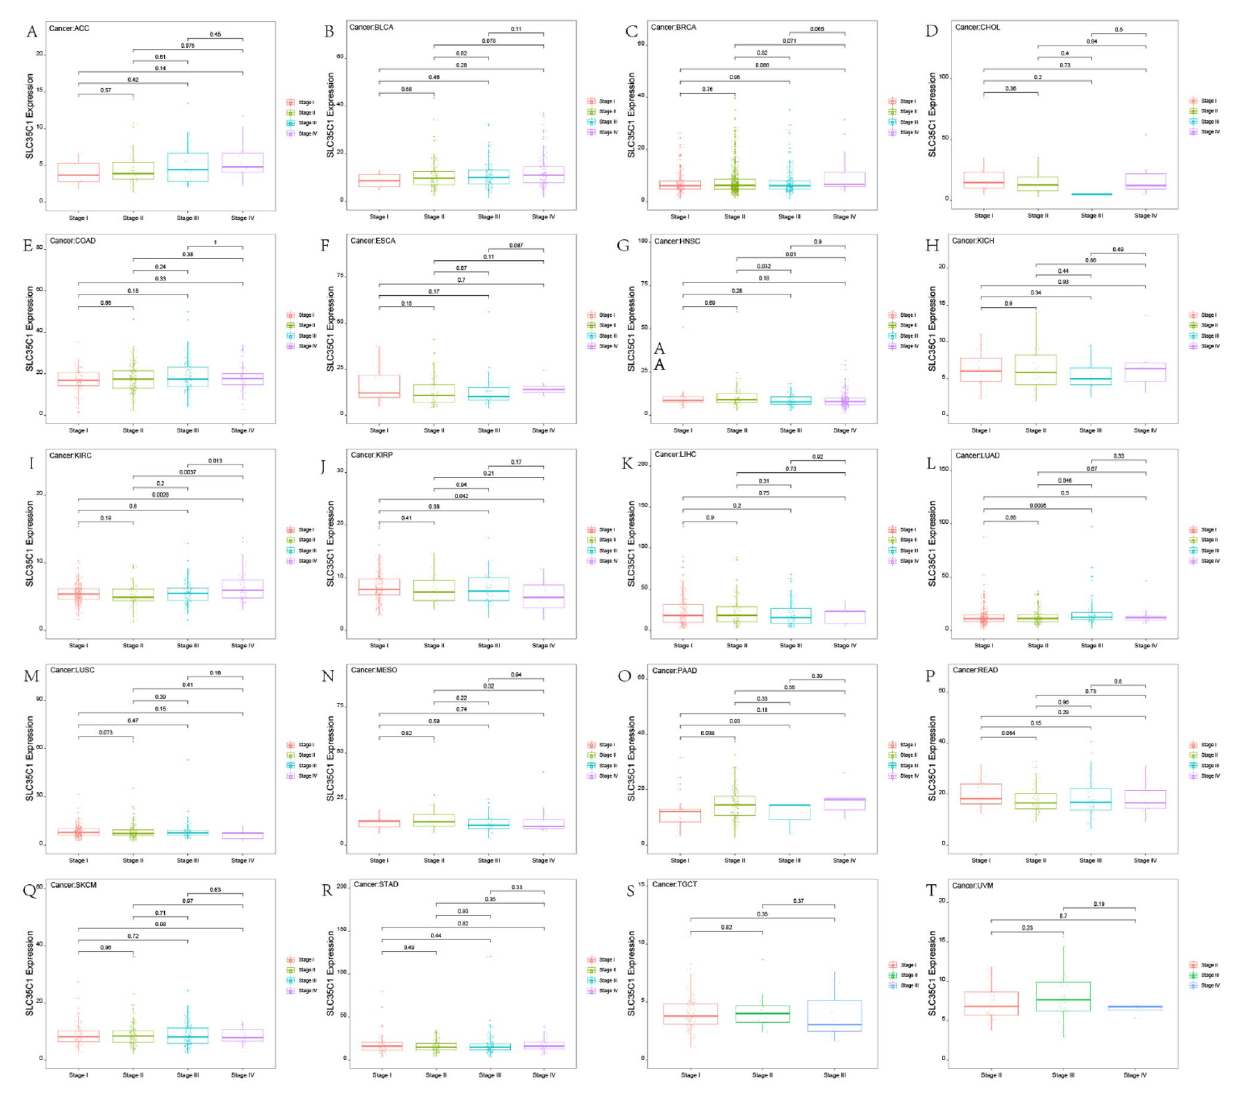
( L ) LUAD, ( M ) LUSC, ( N ) MESO, ( O ) PAAD, ( P ) READ, ( Q ) SKCM, ( R ) STAD, ( S ) TGCT, and ( T ) UVM. Kruskal–Wallis test was used to assess the significance of differences between groups, followed by pair wise comparisons using Dunn’s multiple comparisons test used to evaluate differences among